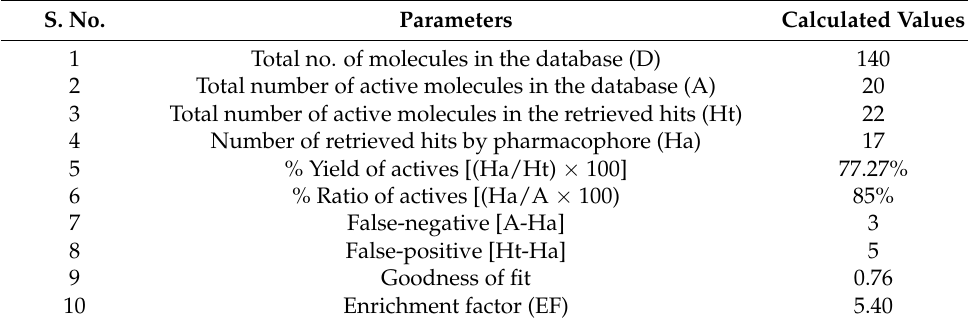
Table 2. The details of pharmacophore validation parameters.